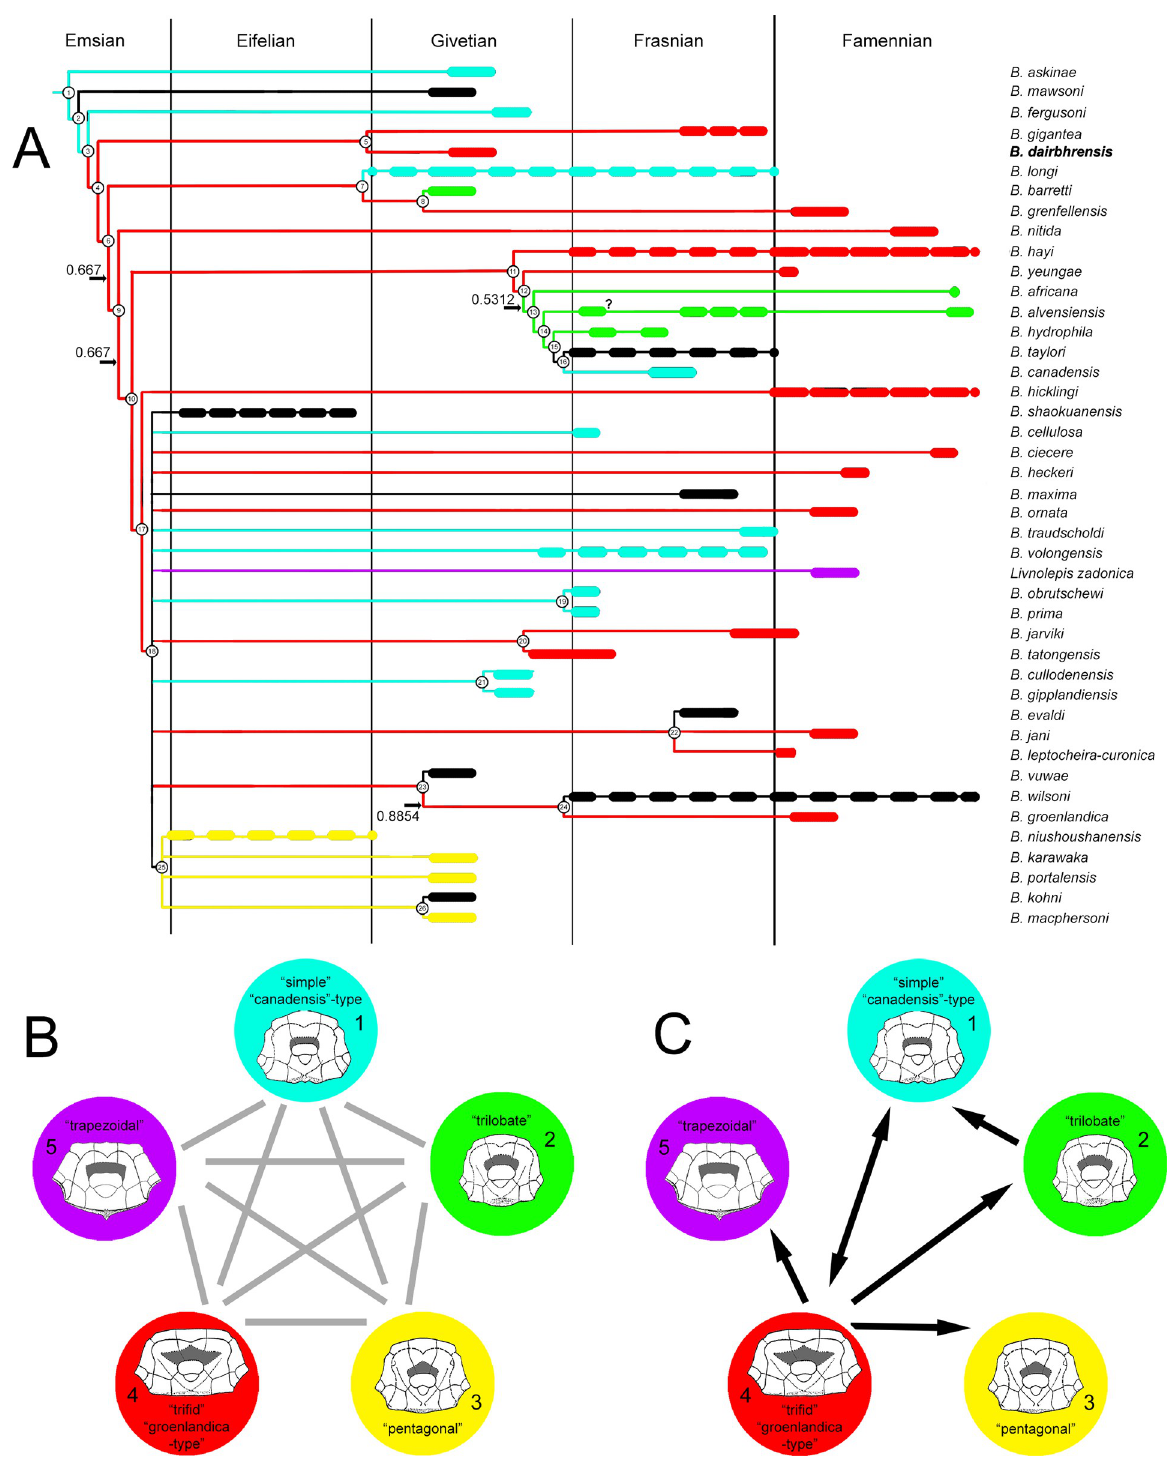
Fig 13. Phylogenetic analysis of the best known species of the genus Bothriolepis [8], with special emphasis on the shape of the preorbital recess. A. Stratigraphy correlated majority rule (50%) consensus tree (n = 96; L 50% = 251; CI 50% = 0.279; RI 50% = 0.365; indices for polytomies in the strict consensus tree are given on the branches; uncertain ranges indicated with longer dashes). B. A priori unordered and unpolarised relationships between the different states. C. Transformation sequence obtained from consensus tree. Colours in cladogram and diagrams correspond to the shape of a preorbital recess: light blue is simple, semi-circular recess (“ canadensis -type”; outline after B . askinae in [25]), green is